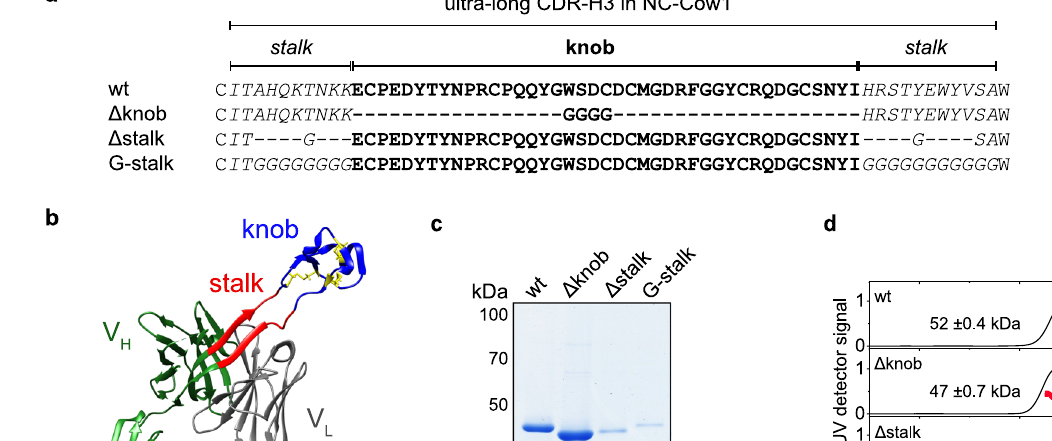
NATURE COMMUNICATIONS| (2021) 12:6737 |https://doi.org/10.1038/s41467-021-27103-z|www.nature.com/naturecommunications